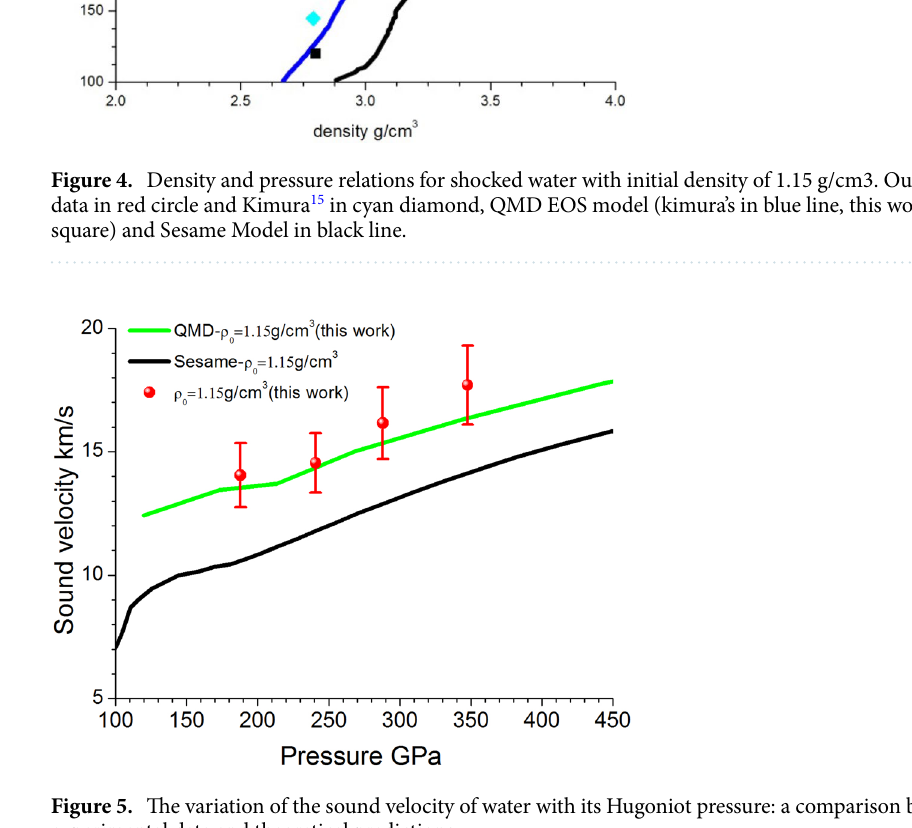
Figure 5. The variation of the sound velocity of water with its Hugoniot pressure: a comparison between experimental data and theoretical